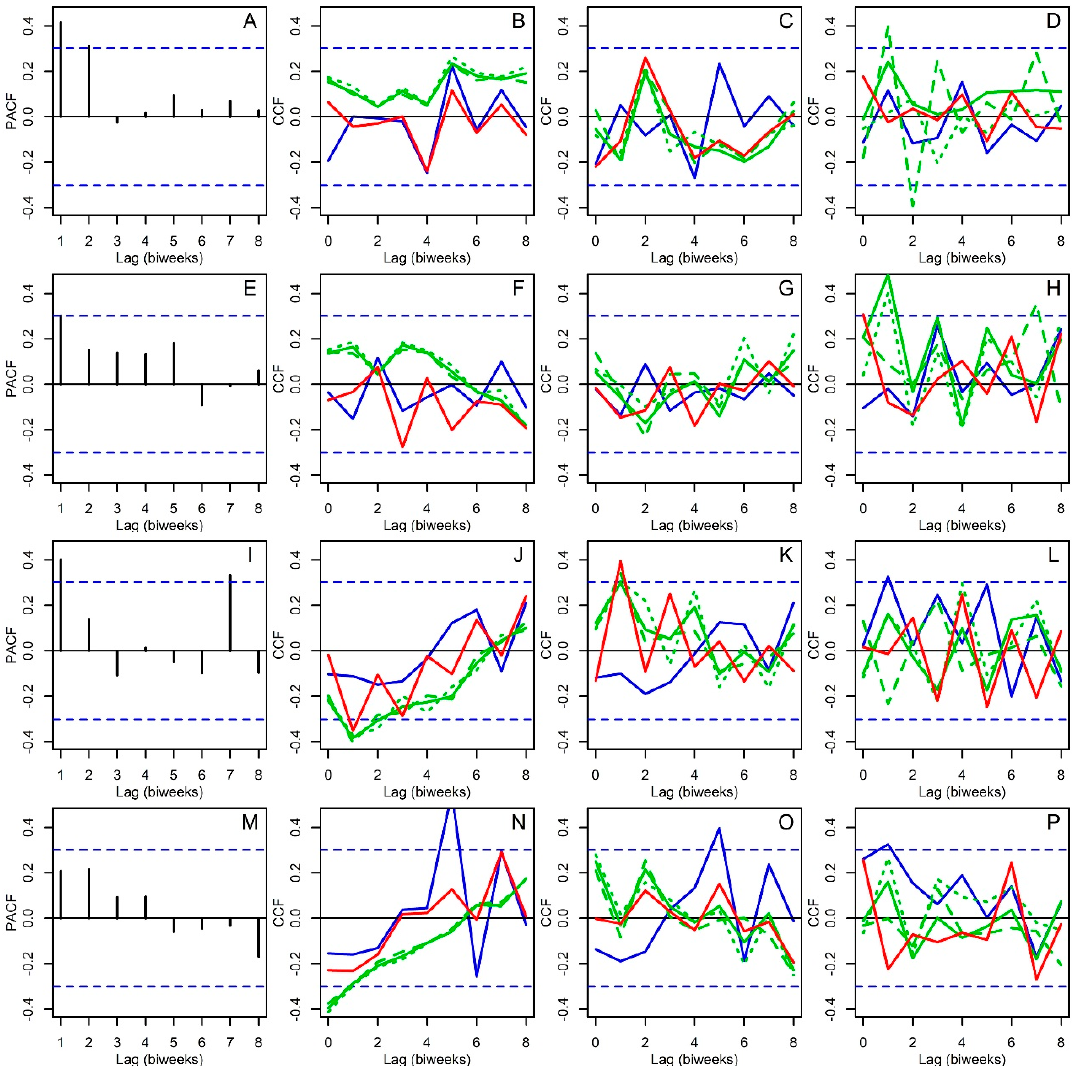
Figure 5. Partial autocorrelation (PACF) and cross correlation functions (CCF). Aedes aegypti in Sanmin: ( A ) PACF and ( B ) CCF with mean values of environmental variables ( C ) CCF with SD values of environmental variables ( D ) CCF with kurtosis values of environmental variables. Ae. aegypti in Nanzih: ( E ) PACF and ( F ) CCF with mean values of environmental variables ( G ) CCF with SD values of environmental variables ( H ) CCF with kurtosis values of environmental variables. Culex quinquefasciatus in Sanmin: ( I ) PACF and ( J ) CCF with mean values of environmental variables ( K ) CCF with SD values of environmental variables ( L ) CCF with kurtosis values of environmental variables. Cx. quinquefascuatus in Nanzih: ( M ) PACF and ( N ) CCF with mean values of environmental variables ( O ) CCF with SD values of environmental variables ( P ) CCF with kurtosis values of environmental variables. In all panels dashed blue lines are 95% confidence limits within which correlations are expected to occur by chance. In the CCF plots lines, environmental variables are color coded following the pattern described in Figure 3.